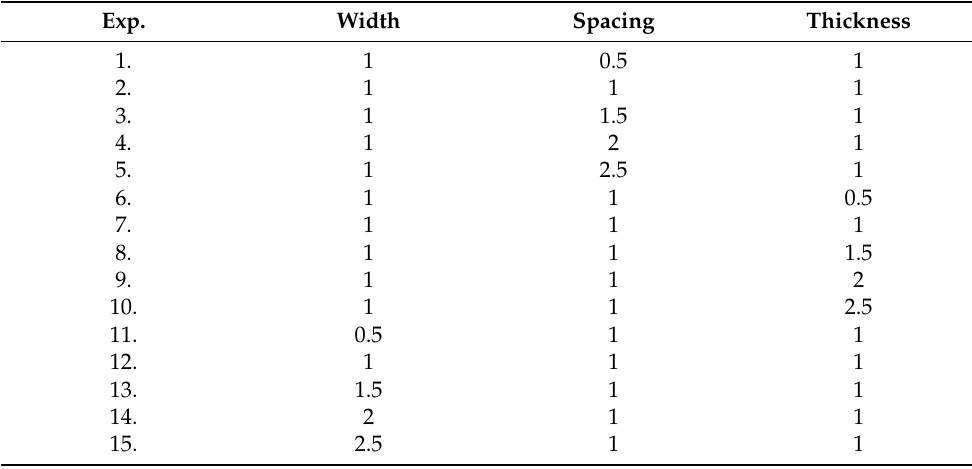
Table 2. Parameter design for sensing layer with different grid microstructures. Exp. Width